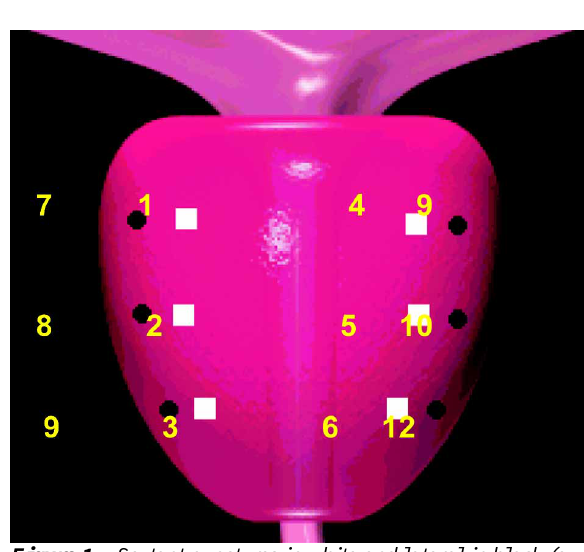
Figure 1 – Sextant punctures in white and lateral in black (au- thorized by Sanofi-Synthelabo).